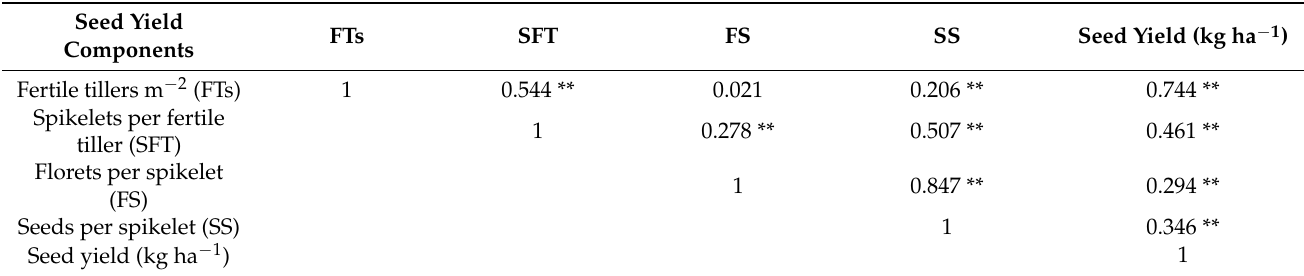
Table 5. Pearson correlation coefficients among seed yield and seed yield components in smooth bromegrass from 2014 to 2018.